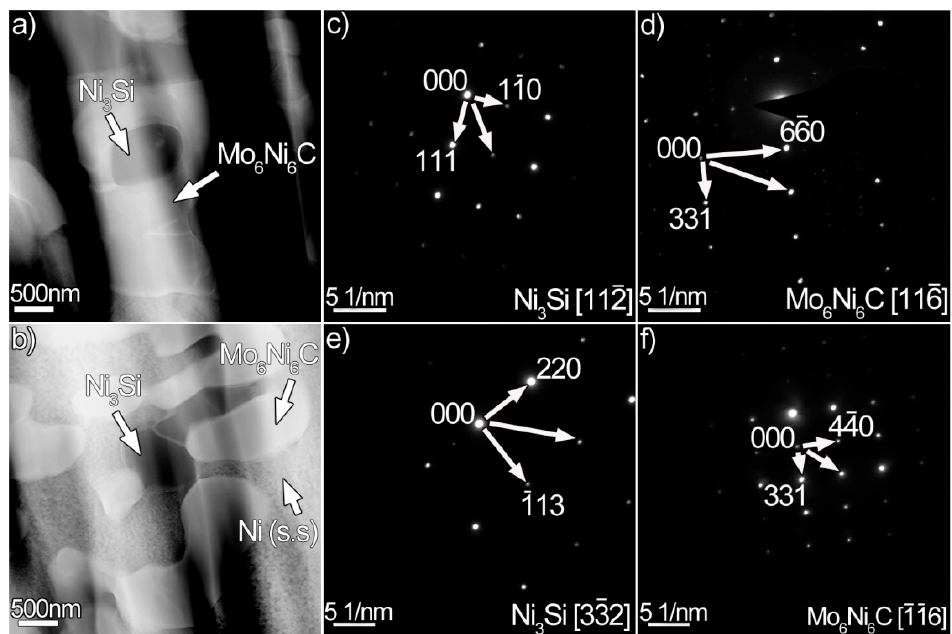
Figure 7. ( a , b ) High-angle annular dark field (HAADF) images of the coating aged for 240 h, ( c , d ) SAED patterns of the Ni 3 Si and Mo 6 Ni 6 C in ( a ), and ( e , f ) SAED patterns of the Ni 3 Si and Mo 6 Ni 6 C in ( b ).